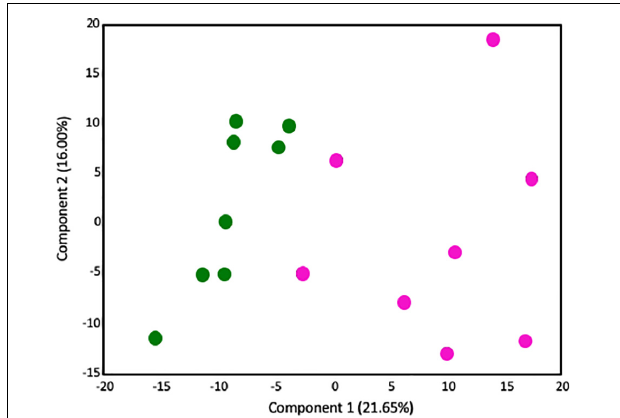
FIGURE 3 | Principal components analysis demonstrates that the global metabolome from LPS-exposed placenta samples is overall distinguishable from the metabolome of control placenta samples. Control placentas: green circles ( N = 8); LPS-exposed placenta: pink circles ( N = 8). The X -axis (Comp1) represents 21.65% of the variability between samples and the Y -axis (Comp 2) represents 16.00% of the variability between